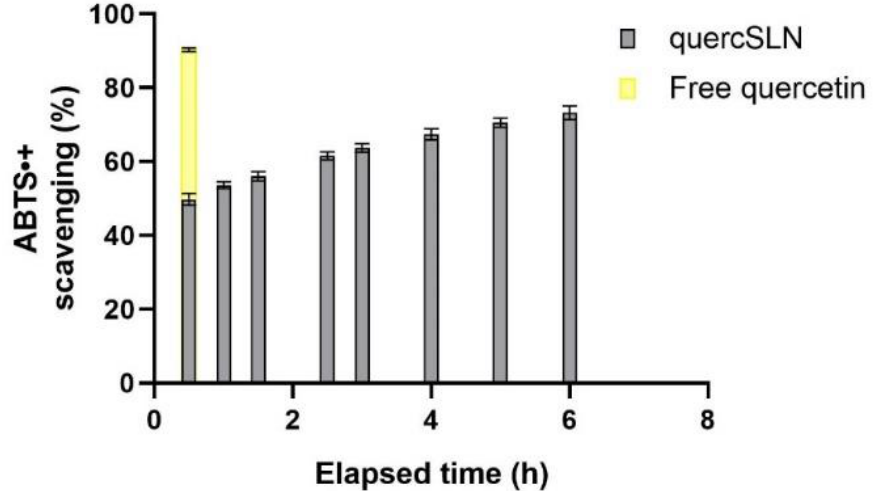
Figure 8. Time-dependent antioxidant activity of QuercSLN compared to that of a free Quercetin solution of the same concentration.